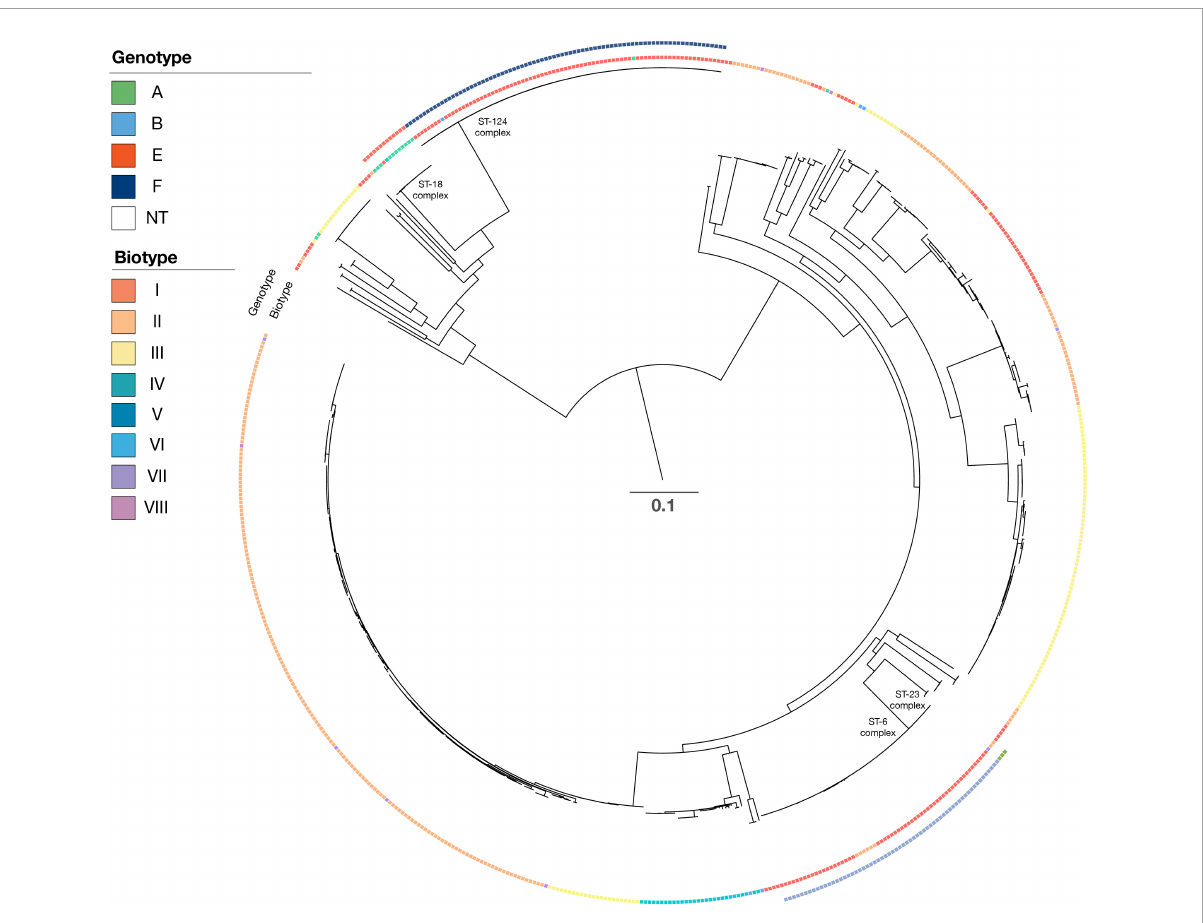
FIGURE2 Phylogenetic tree of all isolates. For each isolate, data are presented for the serotype (genotype with color), biotype (biotype with color), and clonal complex. Isolate Hinf Rd KW20 (GenBank nb. L42023) was used as a reference strain in the SNP alignment. Scale bar indicate substitutions per